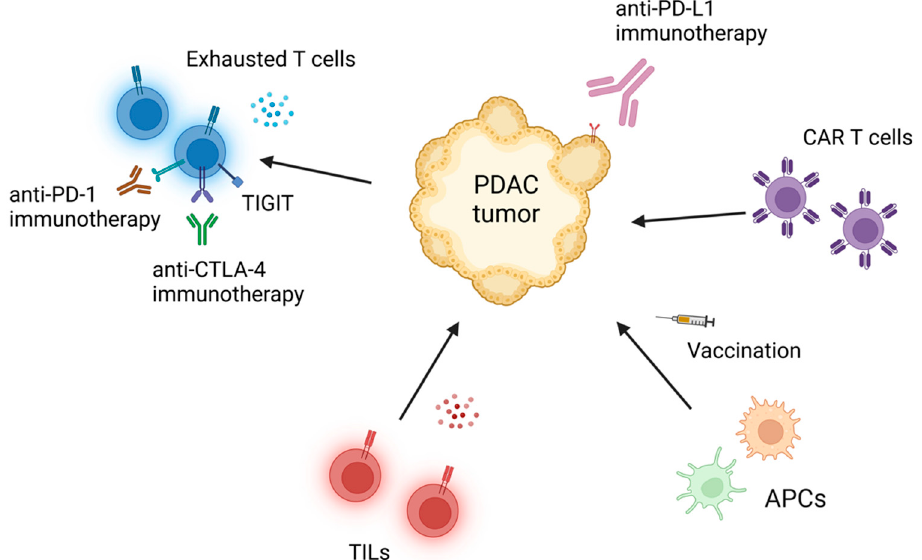
Figure 2. Immunotherapeutic approaches to the treatment of PDAC that leverage the tumor immune microenvironment. APC, antigen presenting cell; CAR, chimeric antigen receptor; CTL, cytotoxic T cell; LAG-3, lymphocyte-activation gene-3; PD-1, programmed death receptor-1; PD-L1, programmed death-ligand 1; T ex , exhausted T cell. Adapted from [39]. Created with BioRender.